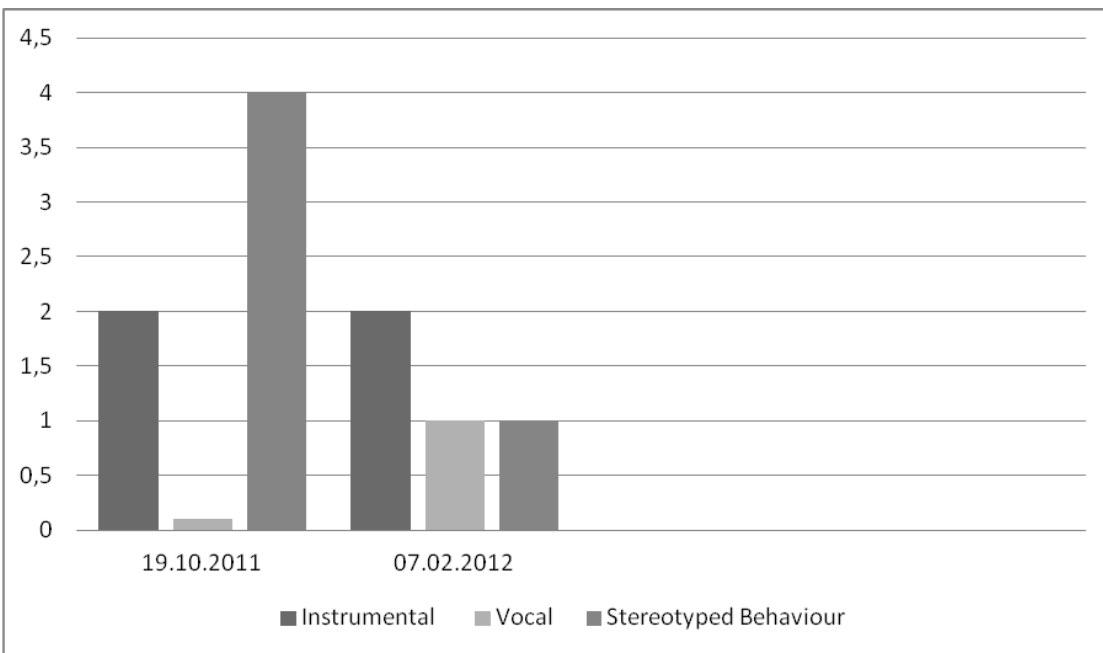
Fig. 3. Participation in musical interaction (a nine-year-old)